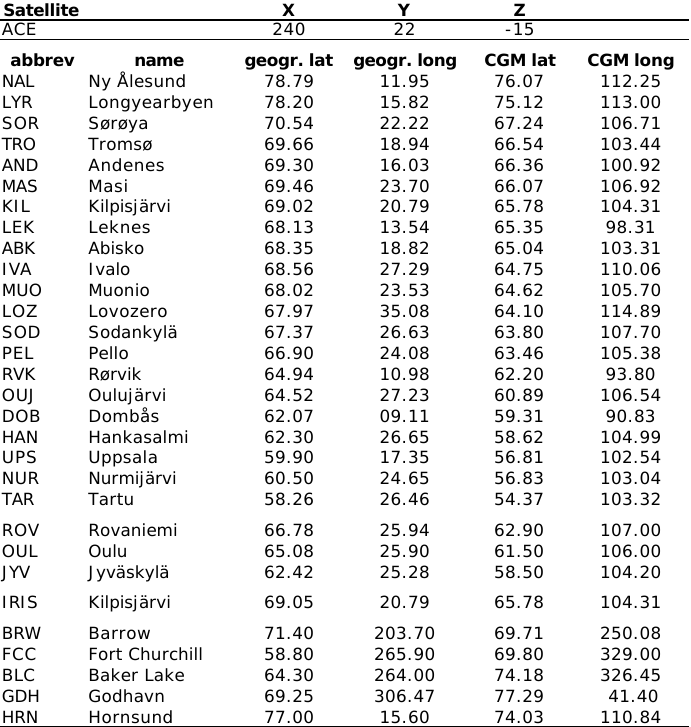
Table 1. The parameters of the IMAGE, SAMNET, Finnish riometer and pulsation magnetometers. Satellite X Y Z ACE 240 name geogr. lat geogr.